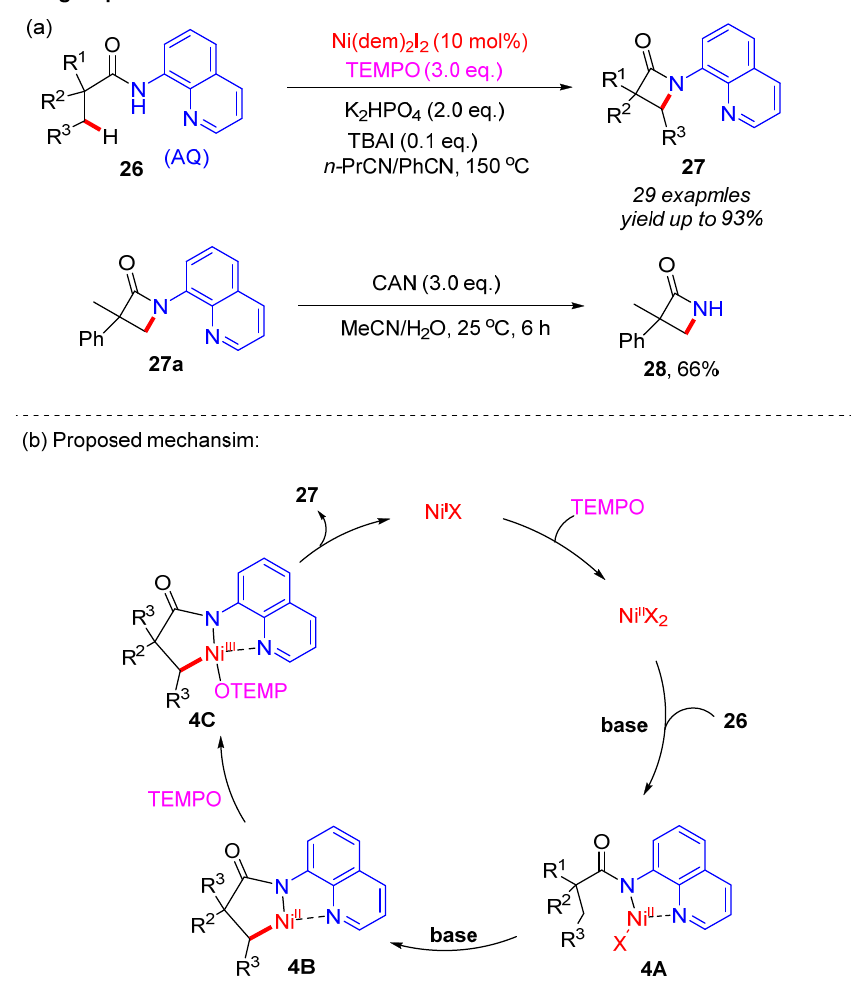
hydrogenative cyclization of aliphatic amide; ( b ) Proposed